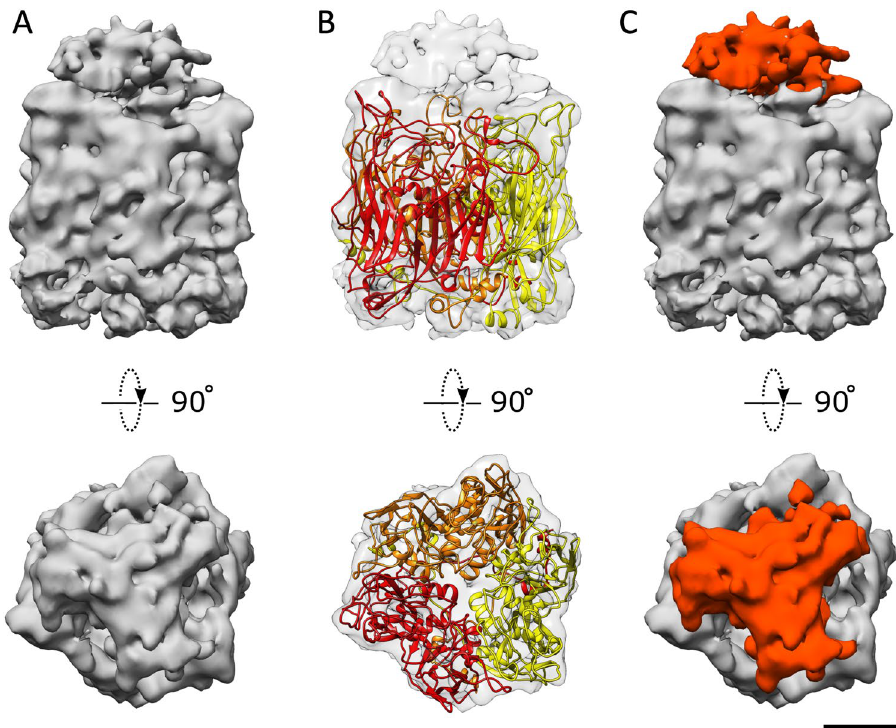
Figure 6. Cryo-EM map and fitted homology model of the tokyovirus MCP trimer. The homology model was generated by SWISS-MODEL 57 and adjusted to the volume with COOT 58 and refined with PHENIX 59 . ( A ) Side and top views of the extracted cryo-EM map of the MCP trimer. ( B ) Side and top views of the extracted MCP trimer cryo-EM map with the homology model fitted. ( C ) Side and top views of the extracted MCP cryo-EM map of the MCP trimer with the additional cap region coloured in red. Scale bar equals 2 nm. The isosurface of the extracted MCP segment is shown at 2